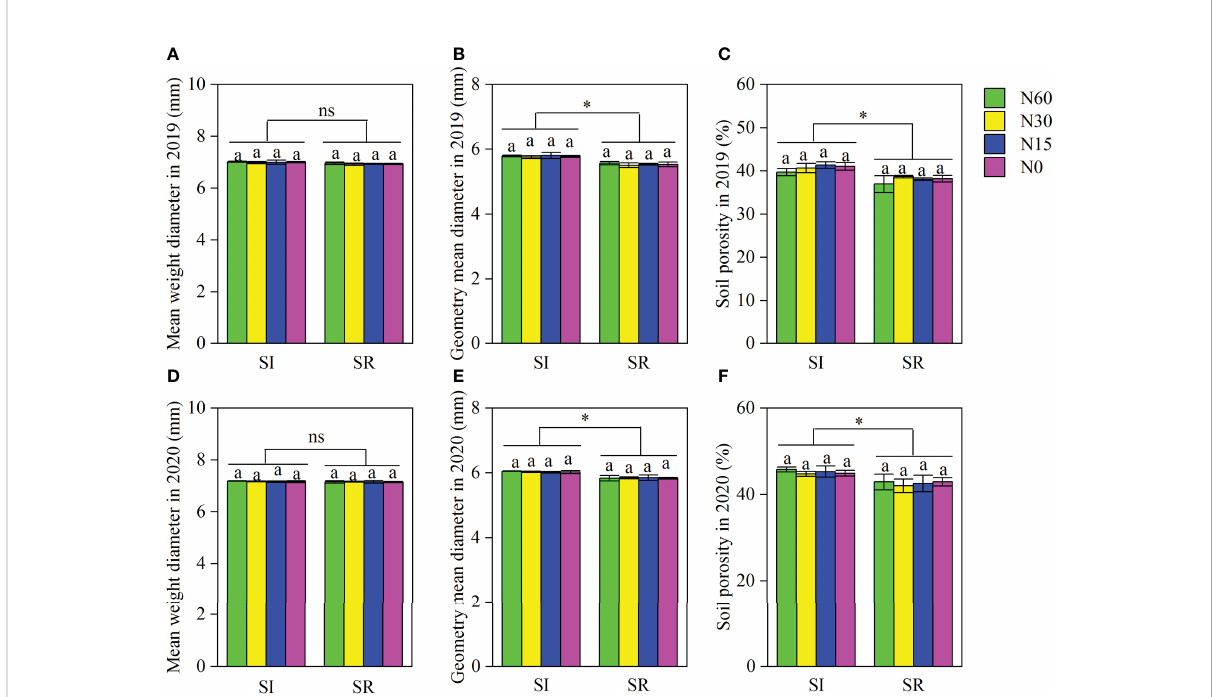
FIGURE 1 Soil physical properties of intercropped soybean at full maturity stage. The same lower-case letters indicate insigni fi cant differences under different N application rates ( LSD , P >0.05). Data were shown as mean ± S.D. (n=3). The asterisk “ * ” and “ ns ” indicate signi fi cant differences ( P <0.05) and insigni fi cant differences ( P >0.05) between straw incorporation and straw removal, respectively. SI, straw incorporation; SR, straw removal; N60, convention N (60 kg N ha -1 ); N30, reduced N by 50% (30 kg N ha -1 ); N15, reduced N by 75% (15 kg N ha -1 ); N0, zero N (0 kg N ha -1 ). (A) , mean weight diameter in 2019; (B) geometry mean diameter in 2019; (C) soil porosity in 2019; (D) , mean weight diameter in 2020; (E) geometry mean diameter in 2020; (F) soil porosity in